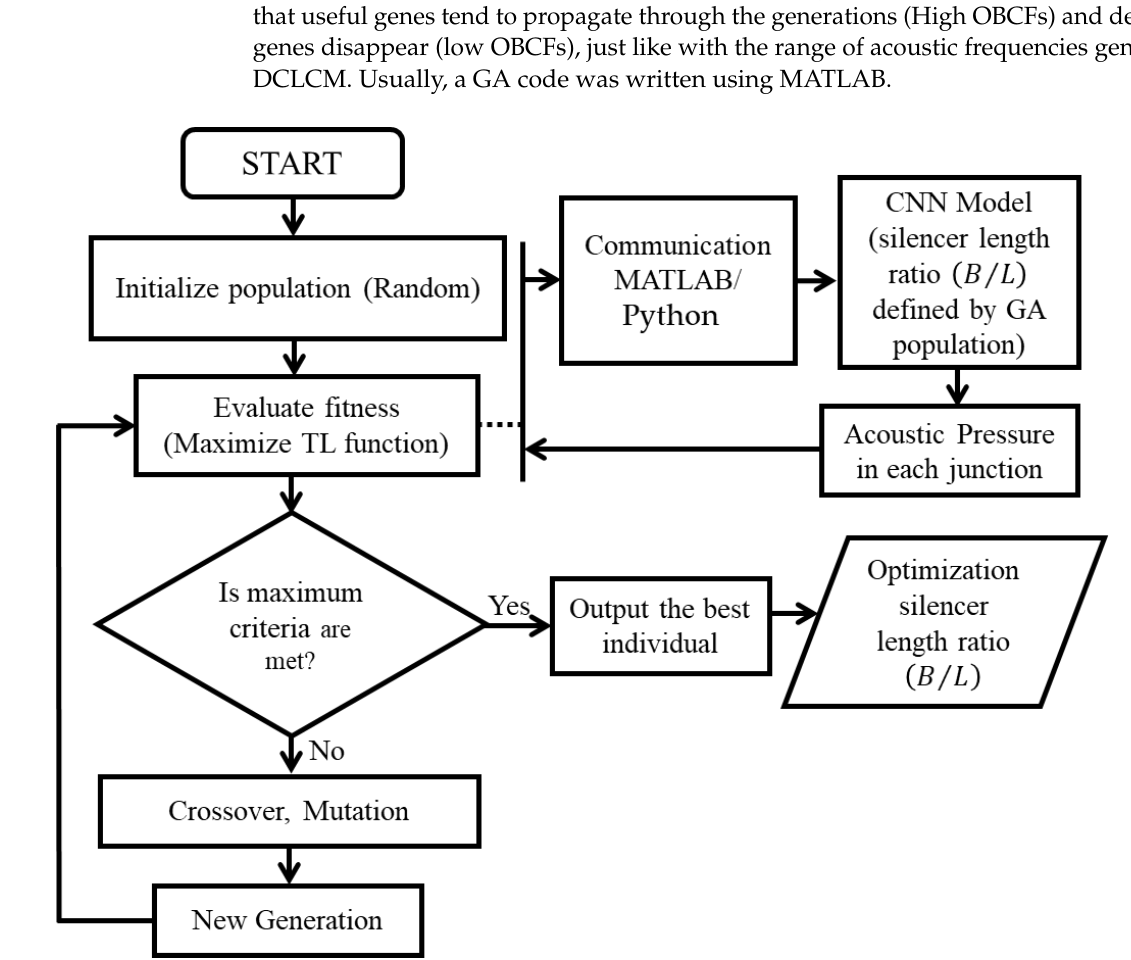
Figure 17. The flowchart of optimization methodology.